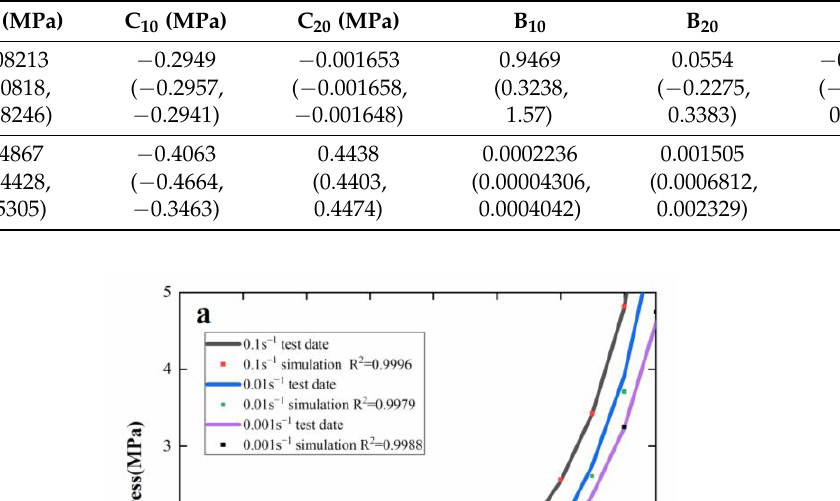
Table 5. Parameters of constitutive model in compression test.